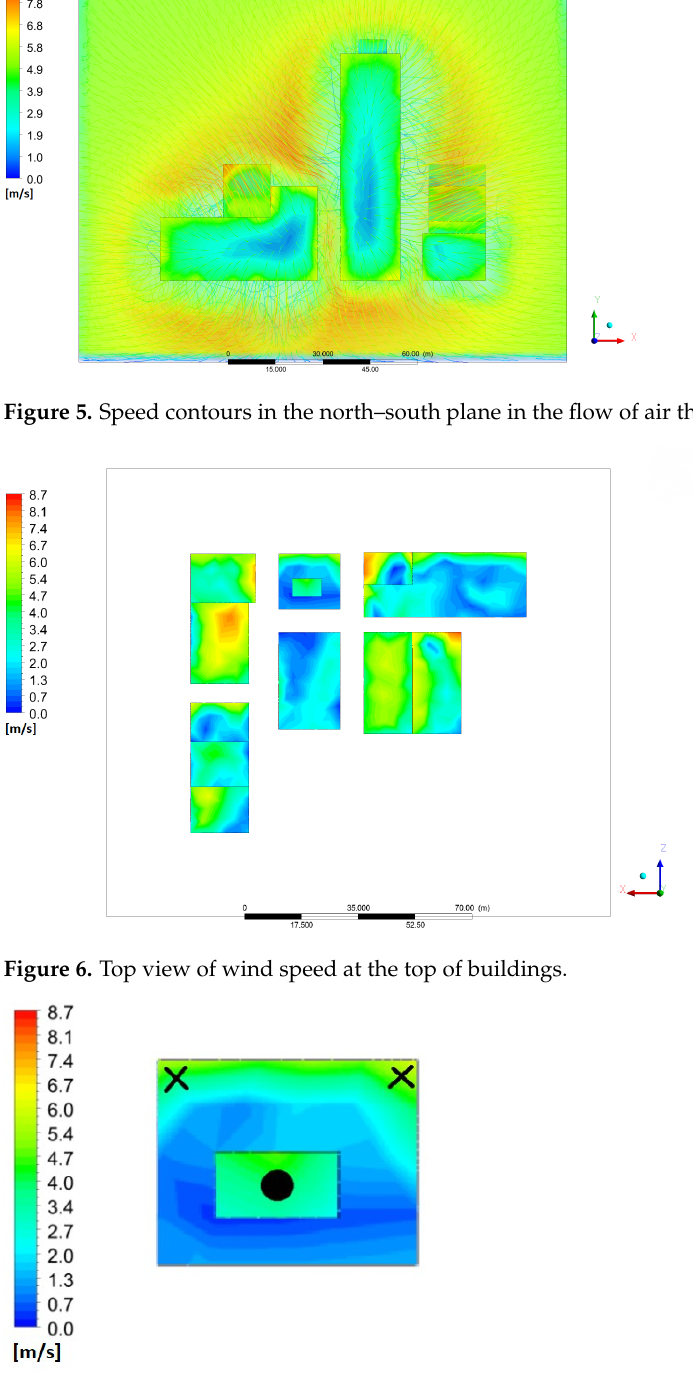
Figure 7. Scenario identification for the installation of wind turbines in the building’s